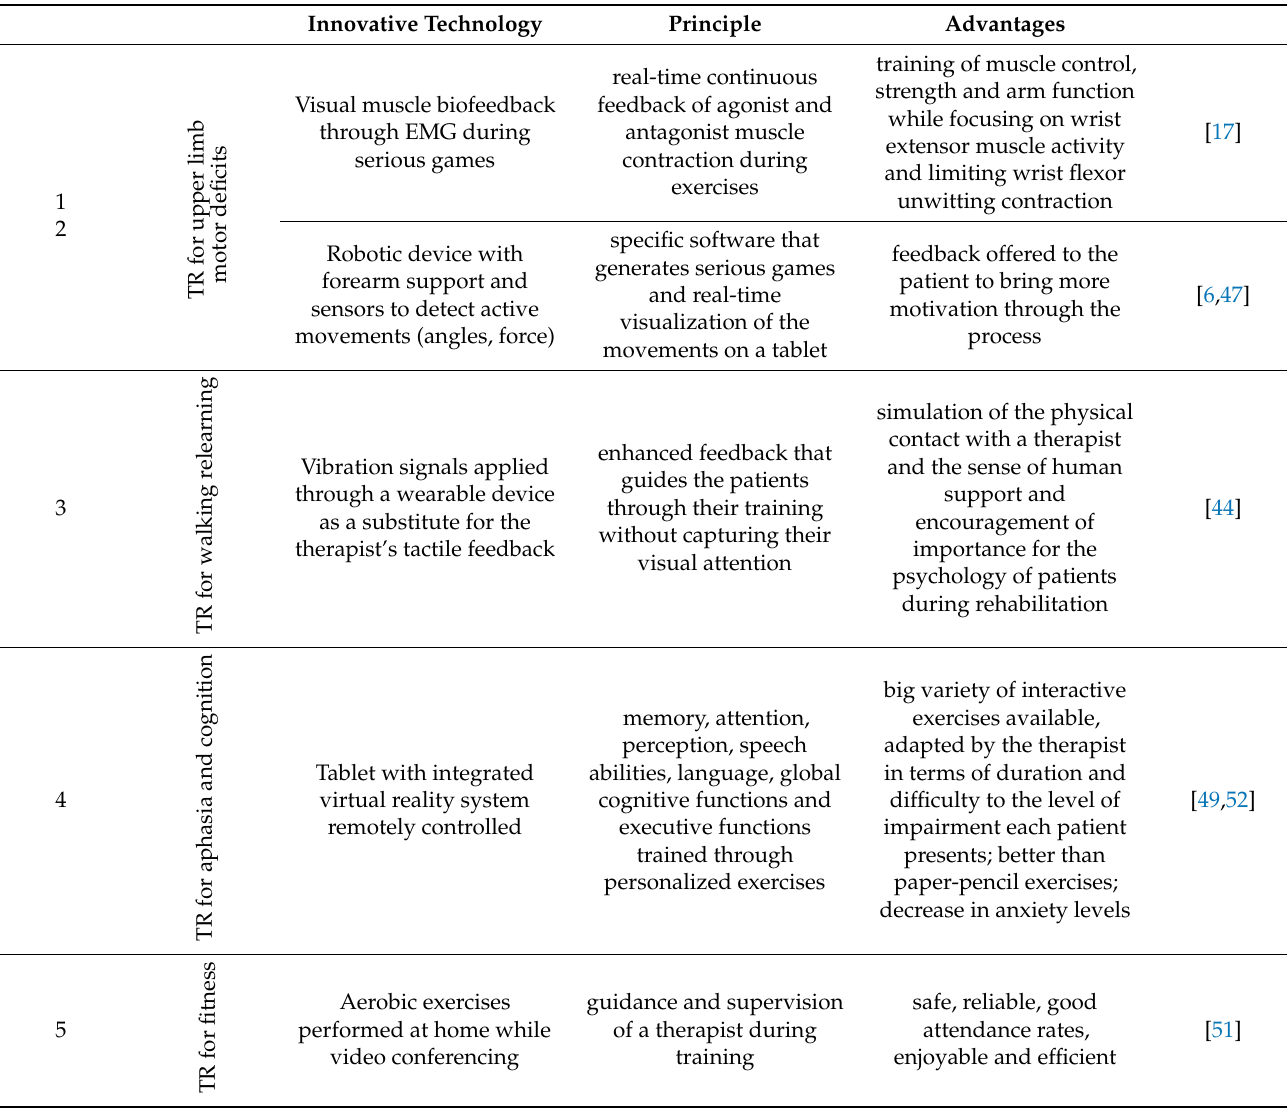
Table 2. Technology for TR